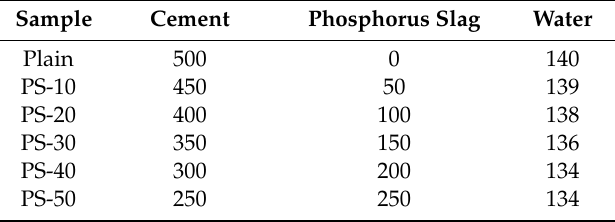
Table 3. Mix proportion of paste samples